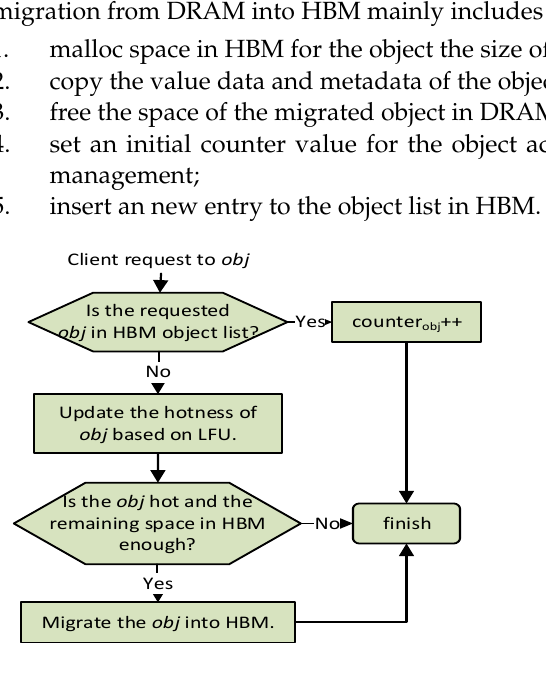
Figure 3. The migration workflow of HBM Migr-in from DRAM to